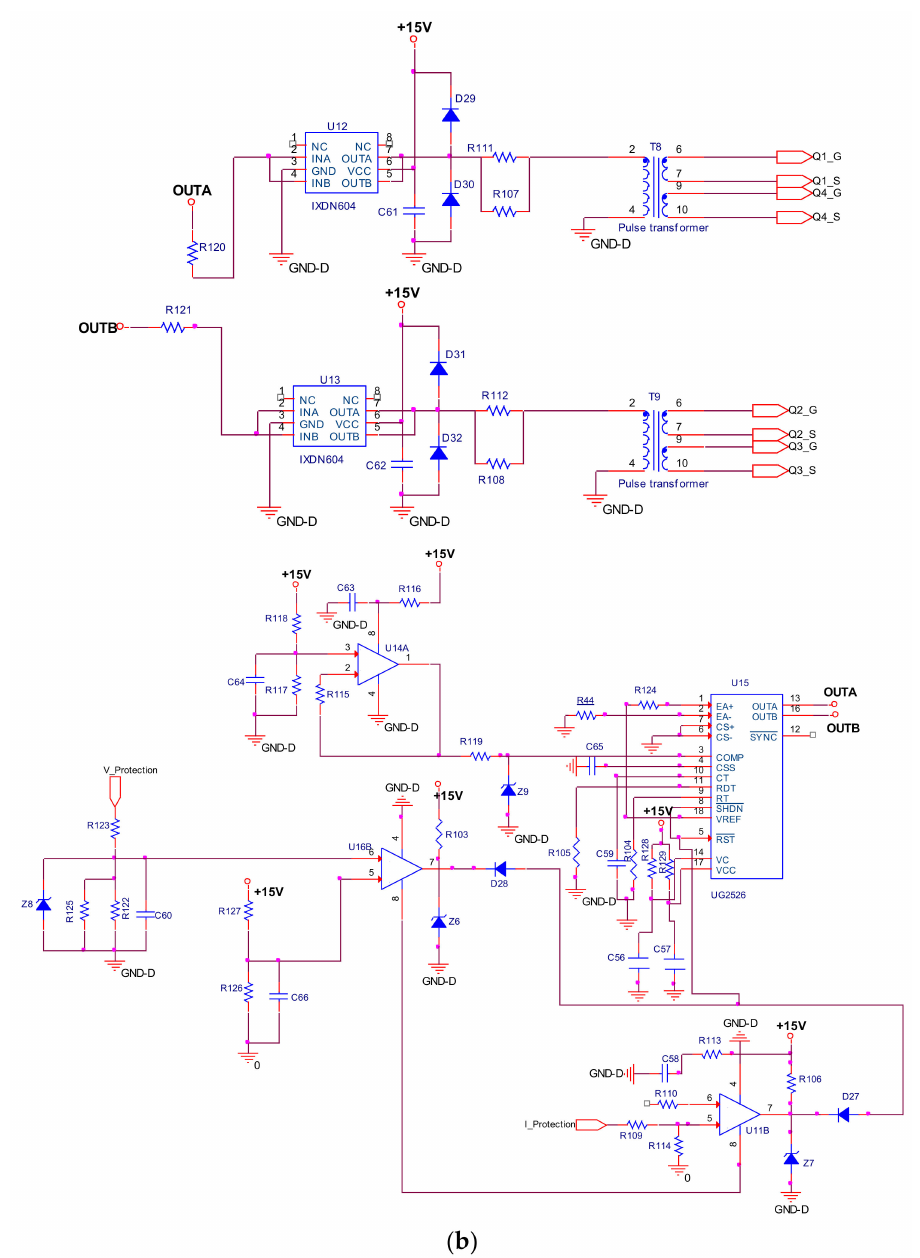
Figure 3. Schematic diagram of 4T analog MOS control HVHF plasma switching power supply. ( a ) Power circuit of HVHF plasma. ( b ) MOSFET driver circuit of the PWM